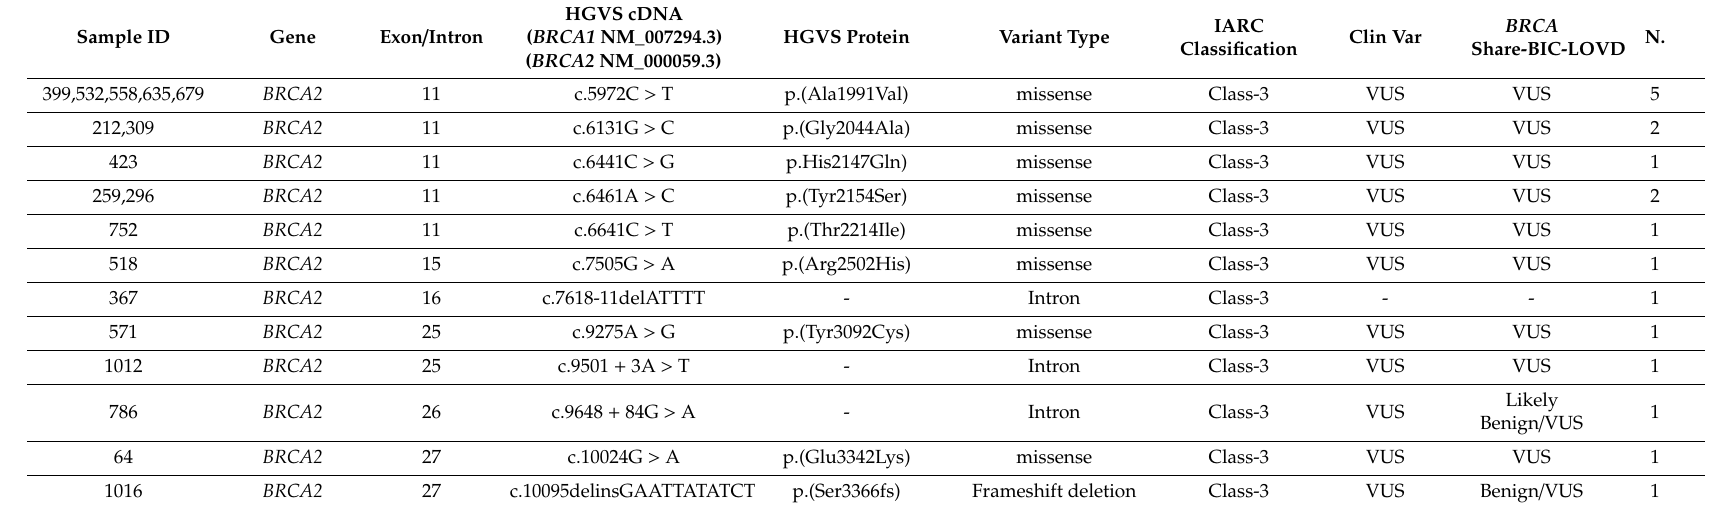
Table 2 (B) List of BRCA1 and BRCA2 Variant of Uncertain Significance (VUS) Variants Detected in 33 Central Italian